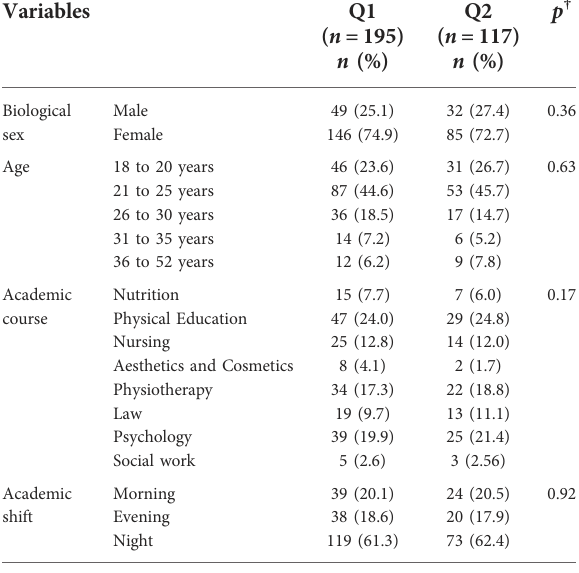
Table 1 Sensitivity analysis based on sociodemographic and academic